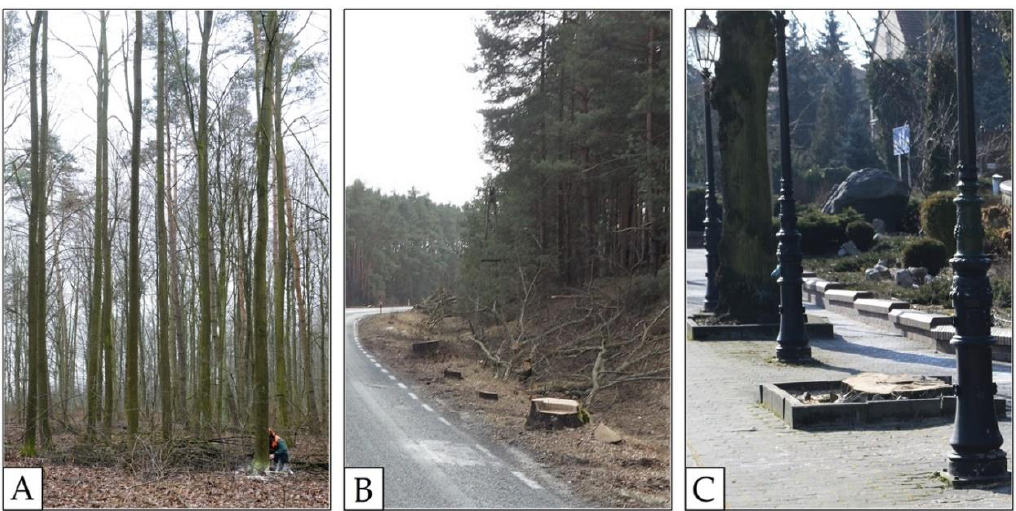
Figure 2. The illustration of the growth environment of the compared Tilia cordata Mill. trees (A— forest, B—roadside, C—urban agglomeration).